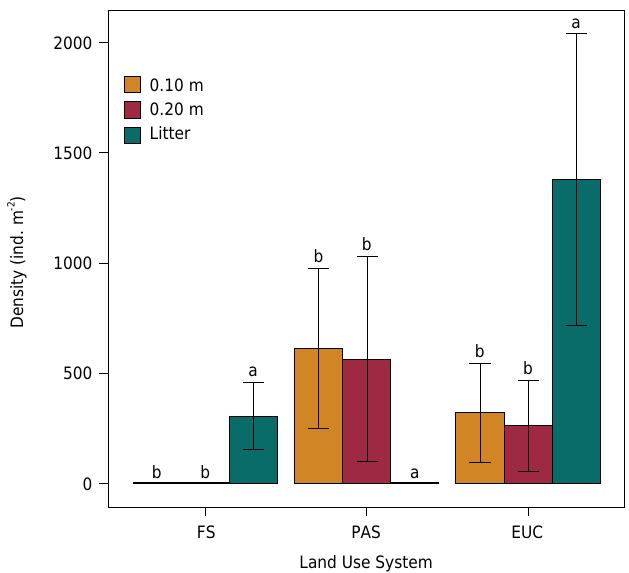
Figure 4. Total density of the Myrmicinae subfamilie in the different LUS and depths in Marabá- PA, Brazil. Mean and standard error. SF: Secondary Forest; PAS: Pasture; EUC: Eucalyptus. Means followed by the same letters in the same LUS do not have a significant difference by the Wilcoxon Signed Rank Test at 5 % of